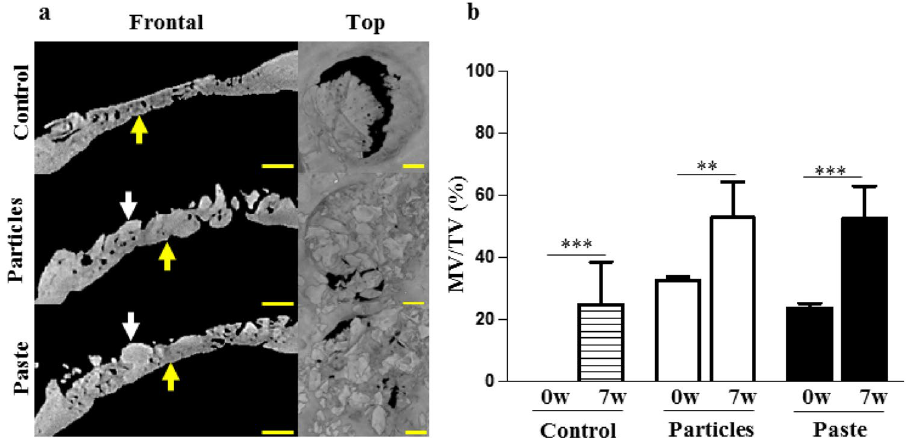
Figure 2. Rat calvaria healing 7 weeks after surgery in a guided bone regeneration model. ( a ) Representative images of the reconstructed µ-CT acquisitions (yellow arrows: newly formed bone, white arrows: grafts). The control represents the defects with the GBR membrane without bone grafts (unfilled defects). Scale bars: 1 mm. ( b ) Three-dimensional µ-CT quantitative analysis of the mineral volume (MV) within the tissue volume (TV) in the defects at the time of surgery (0w, baseline) and 7 weeks (7w) after surgery. The results are expressed as means ± the SD (n = 6) * p < 0.05, ** p < 0.01, *** p < 0.001).